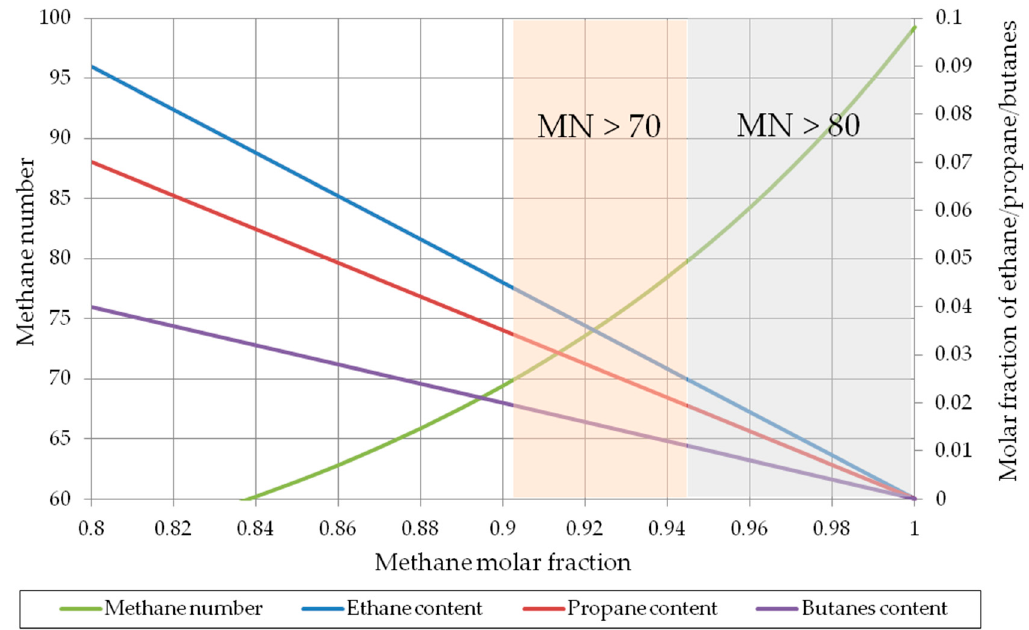
Figure 7. Methane number as function of methane and other components molar fraction for LNG composition set 2.